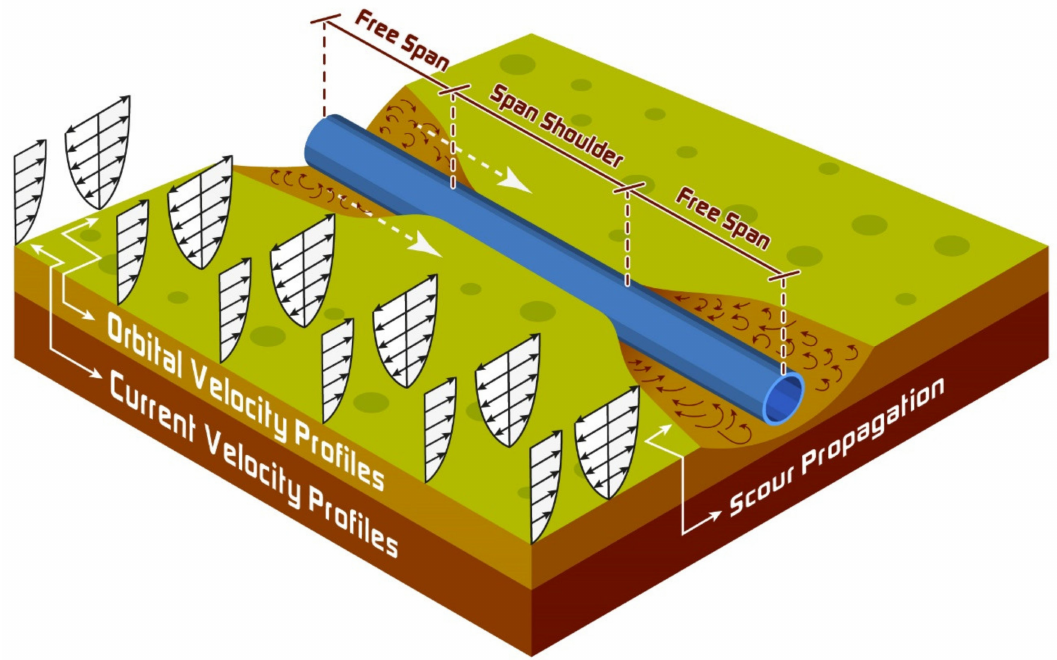
Figure 1. Illustrative sketch of 3D scour hole pattern with free span development at an underwater pipeline under orbital and current velocity